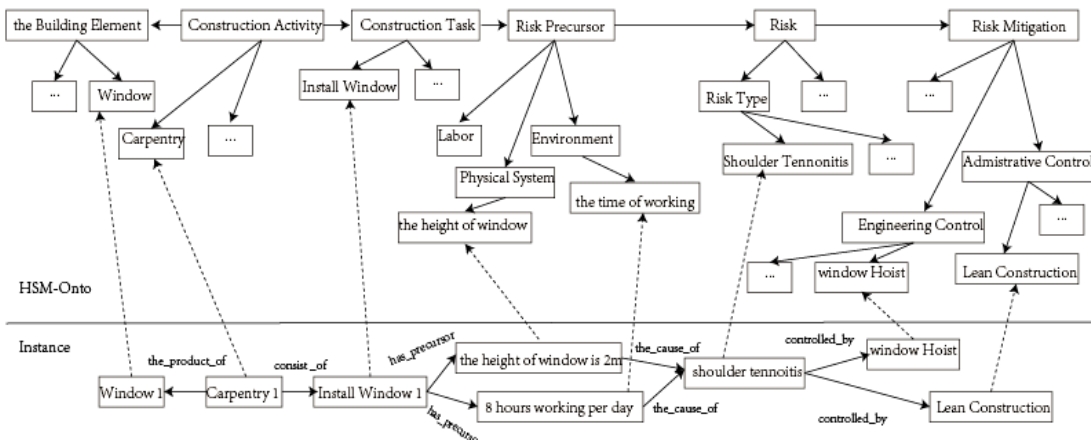
Figure 8. Example of an instance based on the HSM-Onto (shoulder tendonitis risk).